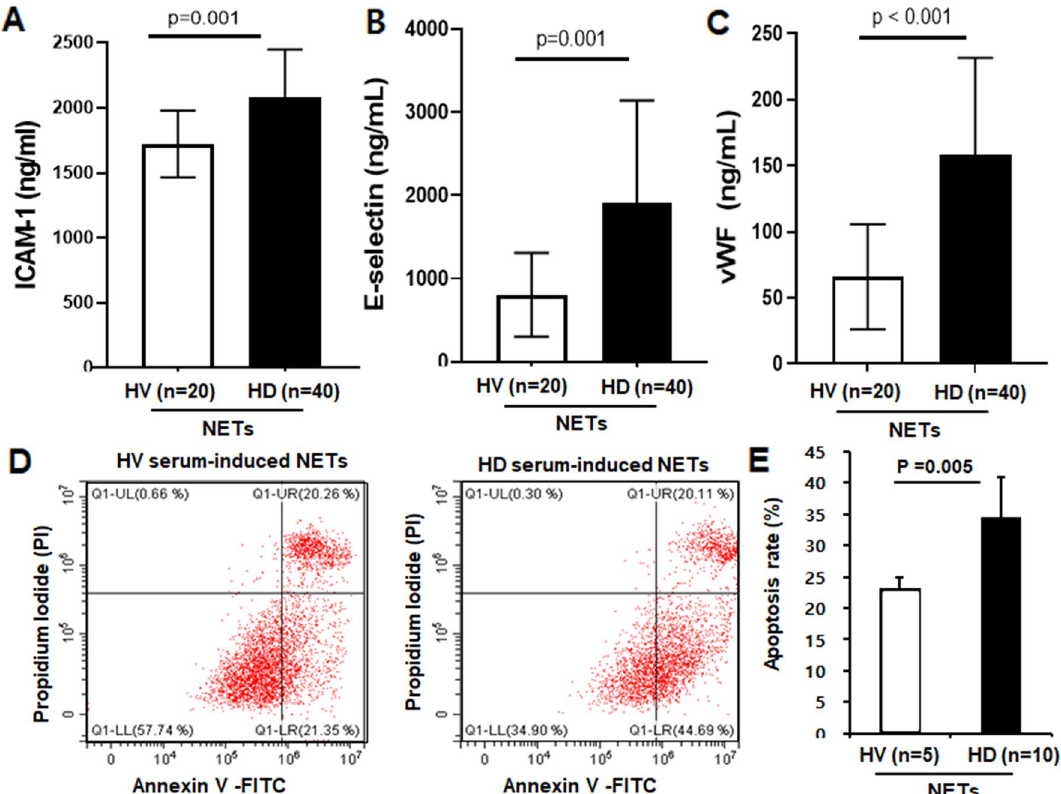
Figure 7. NETs promote apoptosis of endothelial cells. ( A – C ) Intercellular adhesion molecule (ICAM)-1, E-selectin and von Willebrand factor (VWF) levels in HUVEC supernatants as determined by ELISA. The levels were higher with HD serum-induced NETs than for HV serum-induced NETs. Results are means ± SEM, Student’s t -test, ***p < 0.001. To find the apoptosis in HUVEC by NETs, HV or HD serum were applied to dHL60 cells for 17 h. Then, the supernatants (20%) were applied to HUVECs for 20 h, and the cells were fixed and stained with Annexin V and propidium iodide. ( D , E ) FACS analysis. Representative flow plot of the distribution of early apoptosis (Annexin V positive and propidium iodide negative). Percentage of total cells counted. HUVEC Apoptosis was greater for HD serum-induced NETs than HV serum-induced NETs. Results are means ± SEM, Student’s t